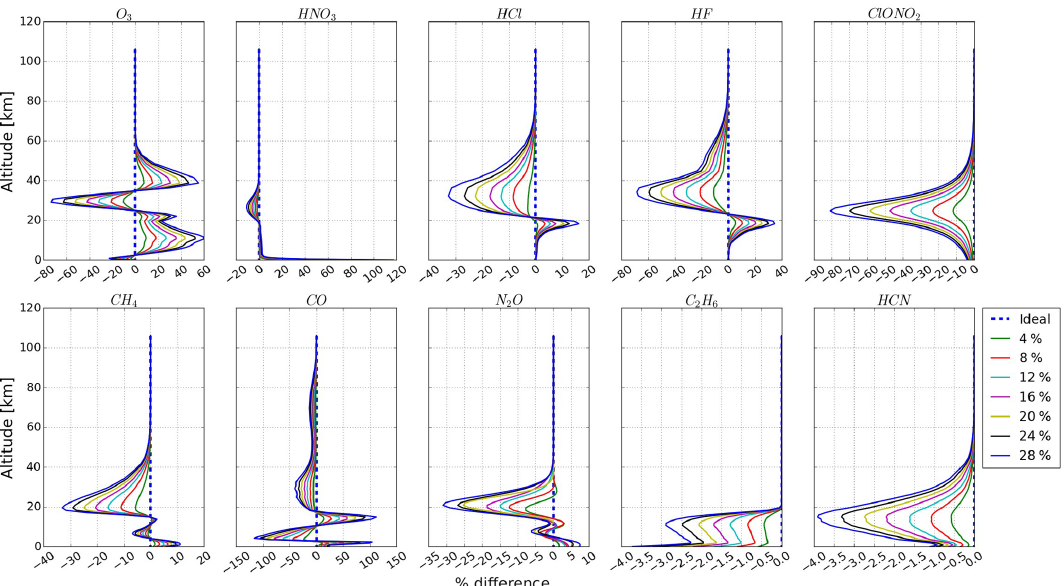
Figure 17. Sensitivity of the profile with respect to ME deviation. “4%” denotes a ME amplitude deviation of 4%. The nomenclature for other plot labels is straightforward. The results are deduced from the spectra recorded at Hefei on 16 February